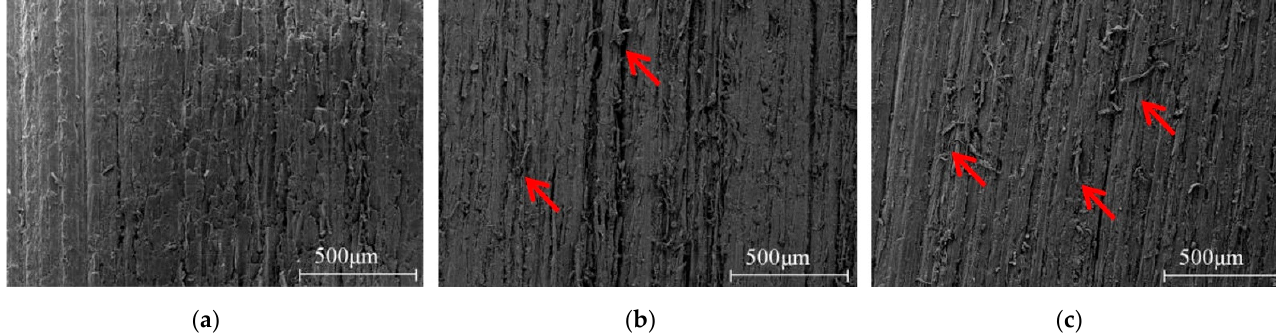
Figure 5. SEM of tangential sections, which were sanded with different mesh sanding belts. ( a ) mesh 60, ( b ) mesh 80, ( c ) mesh 100; the red arrows marked the fibrillation.